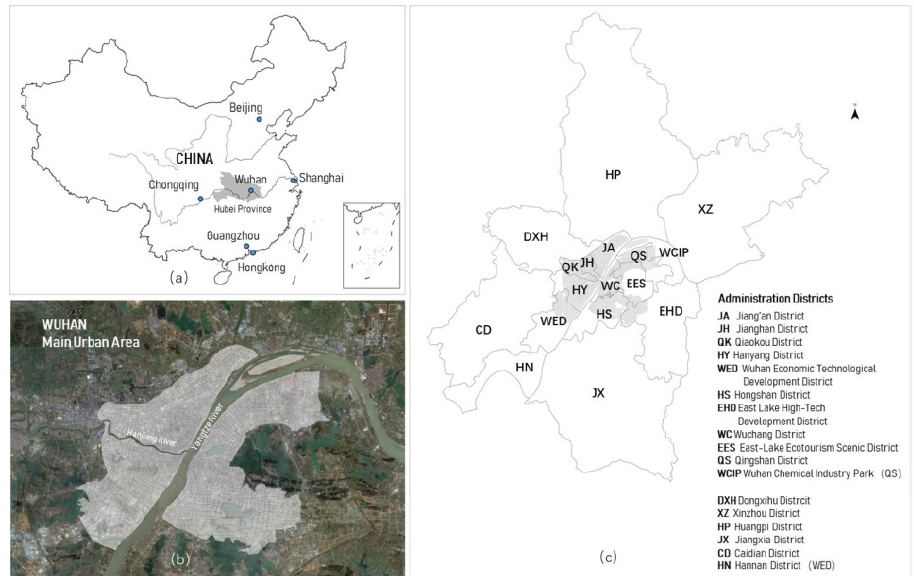
Figure 1. Map of the study area in Wuhan, China: ( a ) the geographic location of the Wuhan, China; ( b ) the main urban area of Wuhan (MUA); and ( c ) administrative districts of Wuhan [8]. Table 1. Case statistics of Wuhan.